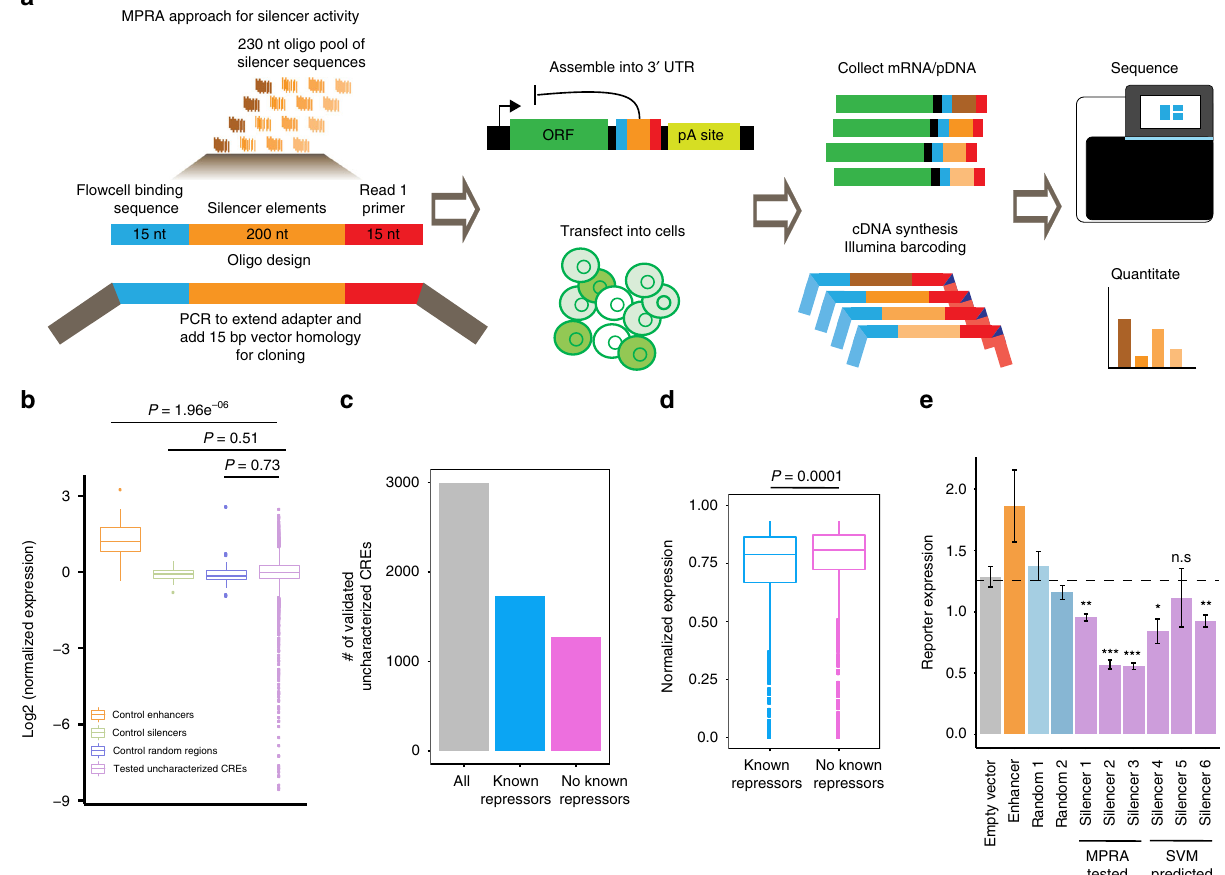
Fig. 2 Functional testing of activity of uncharacterized CREs in K562 cells. a Schematic of MPRA/STARR-seq approach for measuring the activity of uncharacterized CREs. b Box plot displaying the activity level distributions of enhancers, control silencers, control-random regions, and tested uncharacterized CREs. P -values computed by t test. c Bar plot showing the count of all uncharacterized CREs showing silencer activity, and counts of validated uncharacterized CREs overlapping with known repressor TFBS (TFBS belonging to REST, YY1, ZBTB33, SUZ12, and EZH2) or with other TFs motifs. d Box plot comparing the activity level distributions of validated uncharacterized CREs categorized to known repressor TFBS status and other TFs motifs (no known repressor TFBS status). P -value computed by t test. e Bar plot displaying the reporter expression for six silencer elements, two random controls, one enhancer and empty vector (SCP1 core promoter). The dotted horizontal line indicates the mean reporter expression of random regions and acts as a reference. *** denotes signi fi cantly lower reporter gene activity of tested silencer than that of corresponding random controls, and n.s. denotes not signi fi cant (* P -value < 0.05, ** P -value < 0.01, *** P -value < 0.001, and P -values are computed using t test). Error bars represent the mean ± s.e.m. of biological replicates. In the box plots, bounds of the box spans from 25 to 75% percentile, center line represents median, and whiskers visualize 5 and 95% of the data